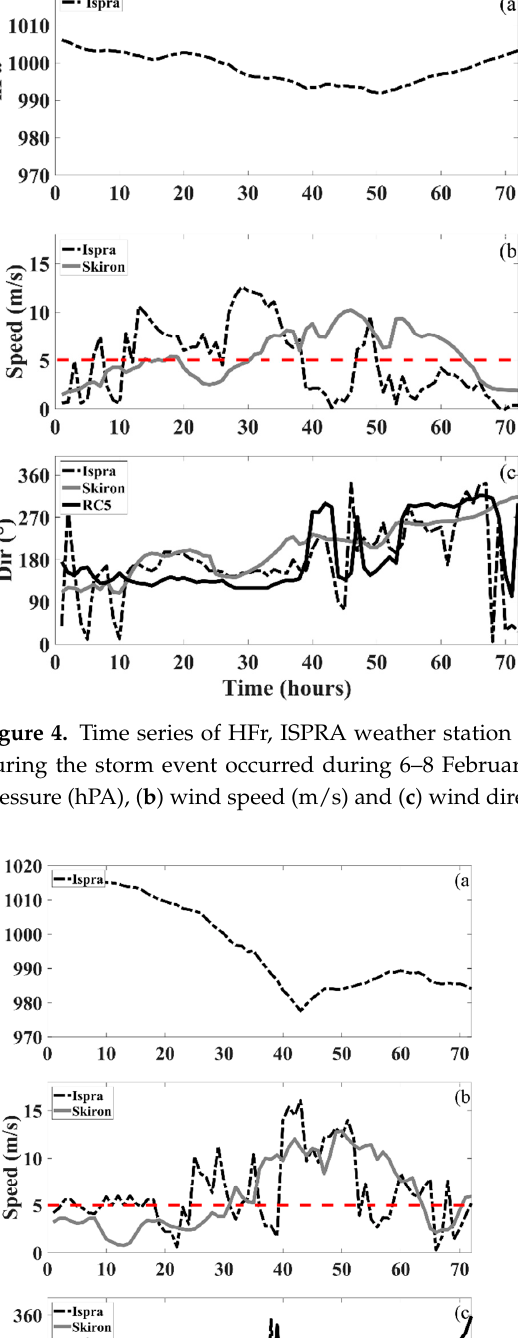
Figure 5. Time series of ISPRA, HFr and SKIRON/Eta model data during the storm event occurred